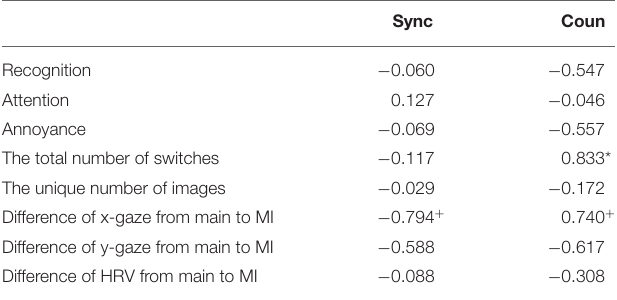
TABLE 2 | Spearman’s correlation coefficient between the distraction and other